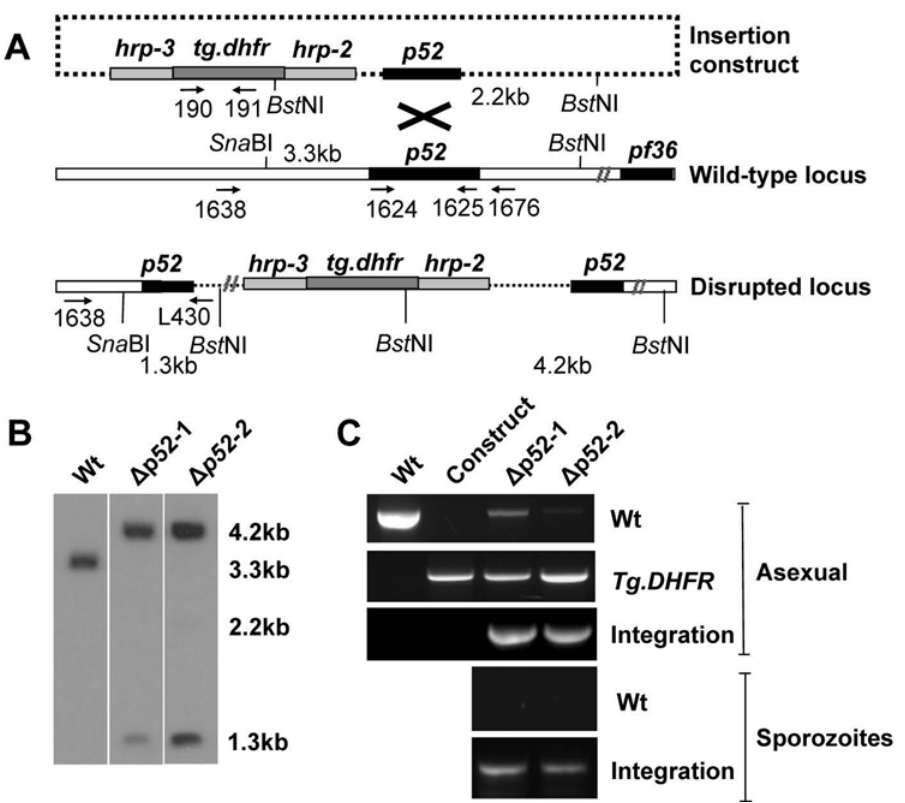
Figure 1. Generation of P.falciparum parasites lacking expression of P52. (A) Illustration of the DNA construct (m144) used for the targeted gene disruption of p52 and the p52 -genomic locus before and after integration. Shown are the p52 gene and target sequence (amplified using 1624 & 1625), the paralog of p52, p36, and the T. gondii dhfr/ts selection cassette. In addition, primer pairs and restriction sites for diagnostic PCR and Southern analysis are shown (see B and C). hrp – histidine rich protein. (B) Southern analysis of BstN I/ SnaB I digested genomic DNA of Wt and D p52 demonstrates correct disruption of p52 . DNA was hybridized with a p52 specific probe detecting a 3.3 kb fragment in Wt, a 2.2 kb fragment for intact plasmid and the expected fragments of 1.3 kb and a 4.2 kb band (see A) in the two D p52 clones ( D p52-1 and D p52 -2 ). (C) PCR analysis of genomic DNA of Wt and D p52 clones and the plasmid DNA (construct) demonstrates correct disruption of p52 . Genomic DNA from Wt and D p52 asexual parasites and sporozoites was used as template for the PCR reactions. The Wt specific PCR was performed using primers 1638 and 1676 amplifying a 2.1 kb fragment. PCR primer pairs 1638 and L430, specific for integration of the DNA construct (see A) amplify a 2.0 kb fragment. Primer pairs 190 and 191 amplifying a 1.8 kb fragment from T. gondii dhfr/ts were used as a control.